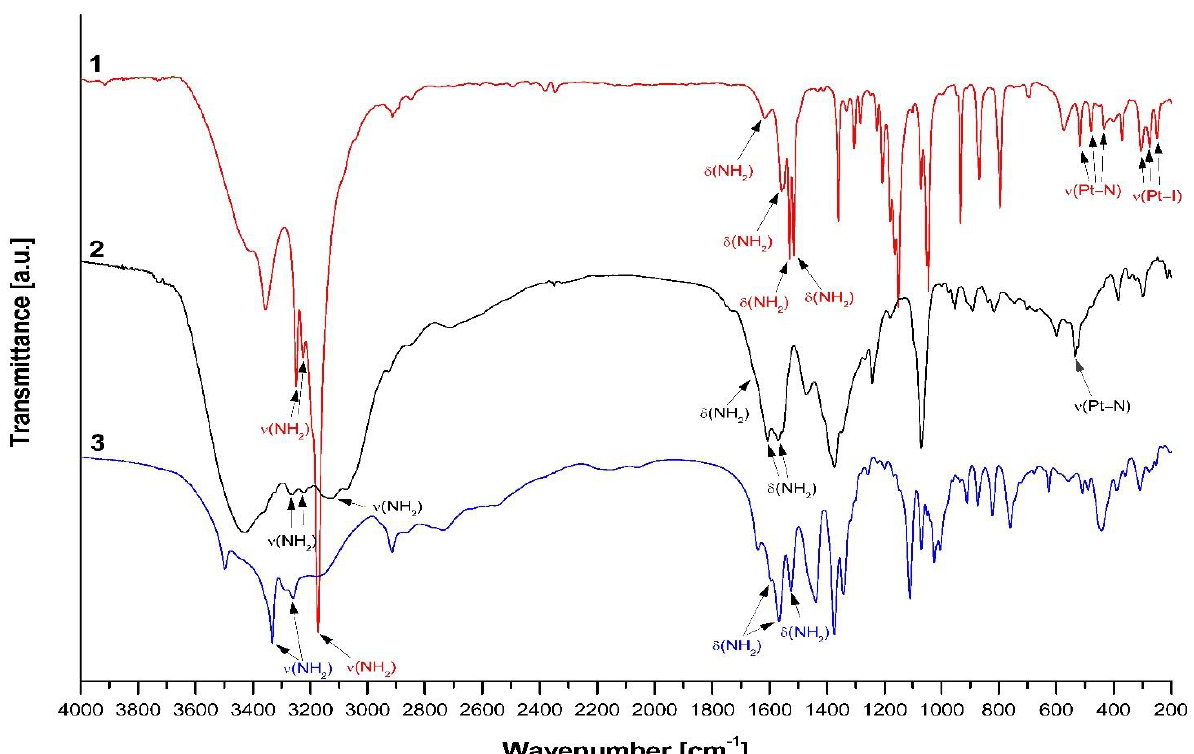
Figure 3. IR spectra (CsI disks): 1 -taciplatin (red), 1A ; 2 -ditaciplatin (black), 2A ; 3 -taci·2H 2 O (blue).